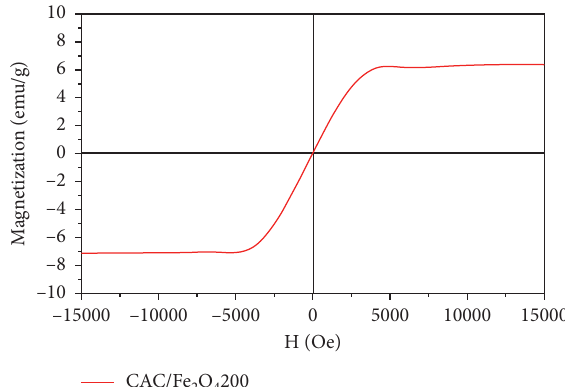
Figure 3: Magnetic hysteresis curves of CAC/CoFe